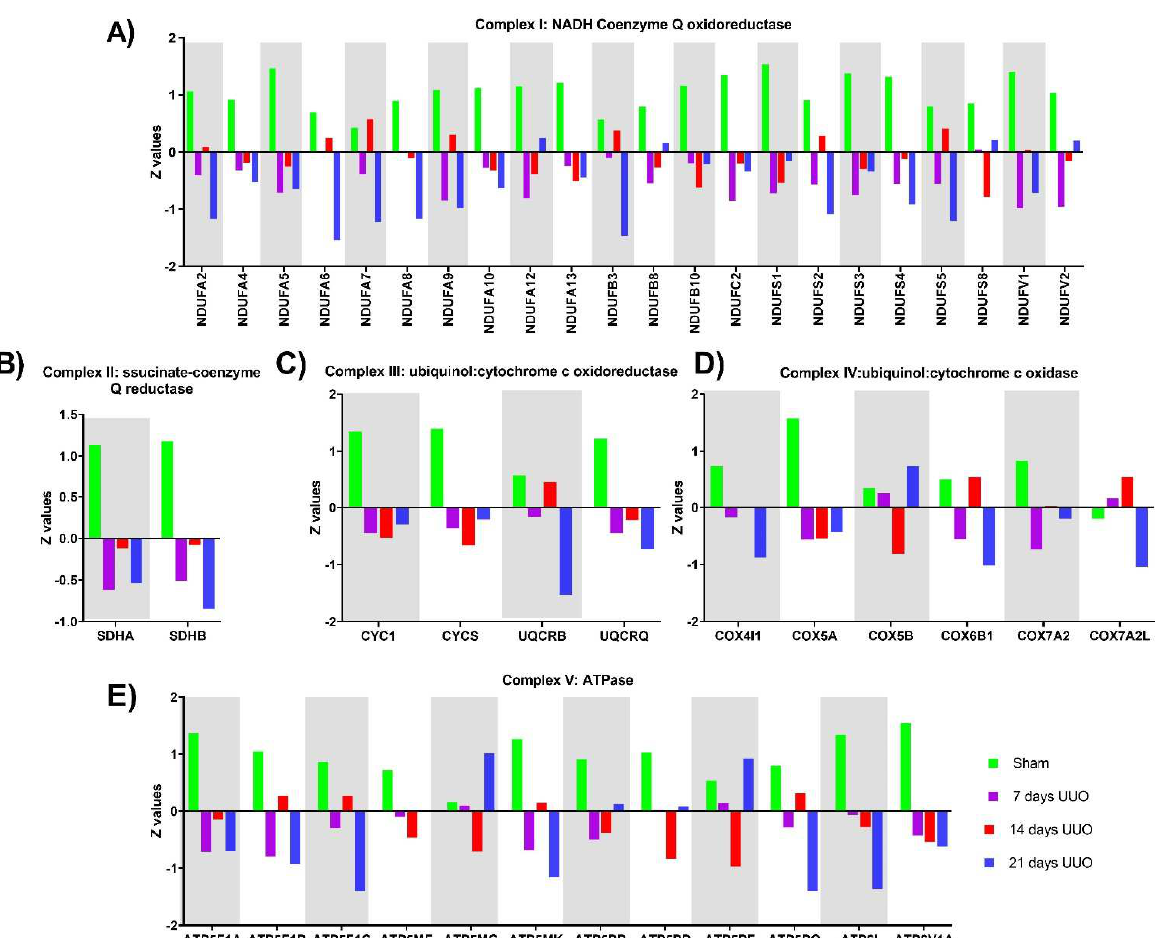
Figure 3. Differentially expressed proteins of electron transport system (ETS) proteins and ATP sybthase (ATPase) in kidney identified by proteomic during 7, 14, and 21 days after the unilateral ureteral obstruction (UUO). ( A – D ) The Z value of the abundance of subunits identified for complexes I, II, III, and IV of ETS in the kidney during UUO progression. ( E ) The Z value of the abundance of subunits identified for complexes V or ATPase in the kidney during UUO progression.